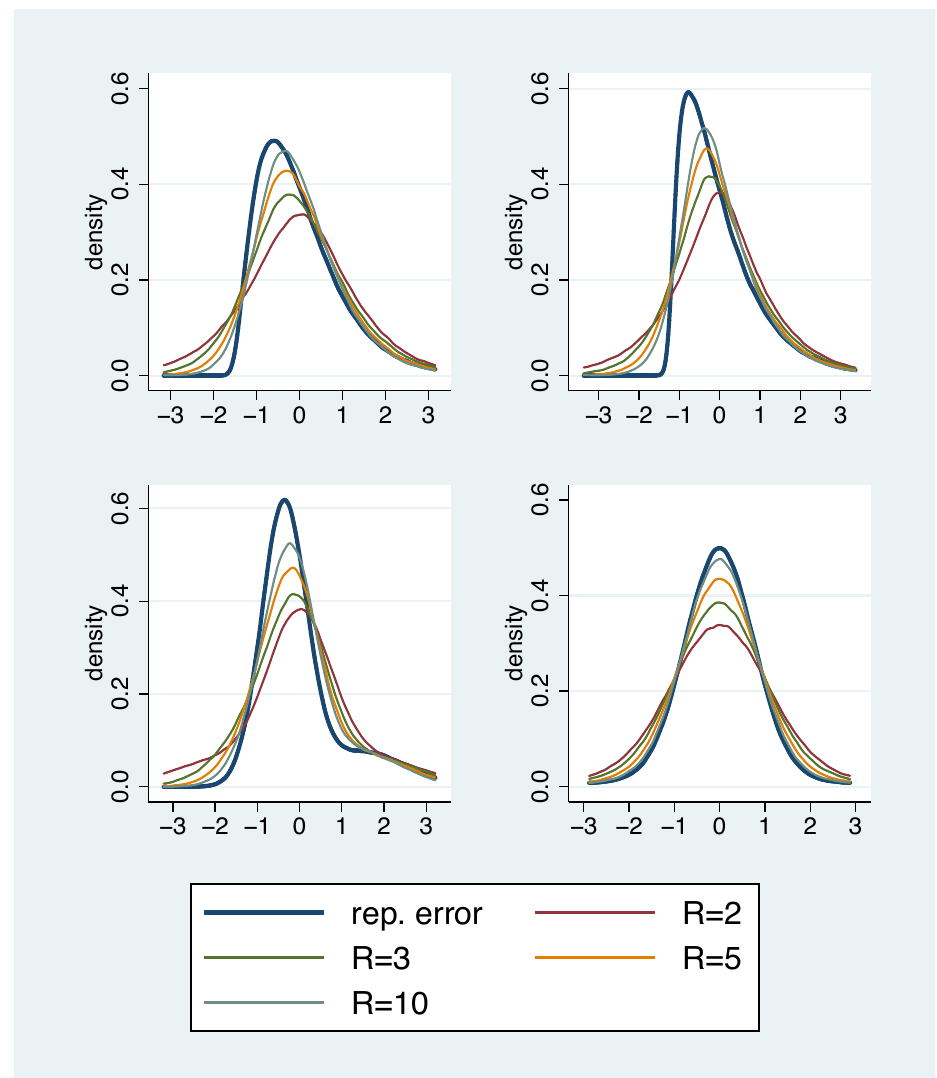
Figure 3. Four repetition error distributions and the corresponding distributions of residuals based on R replicates. Residuals were rescaled by multiplication with the factor R